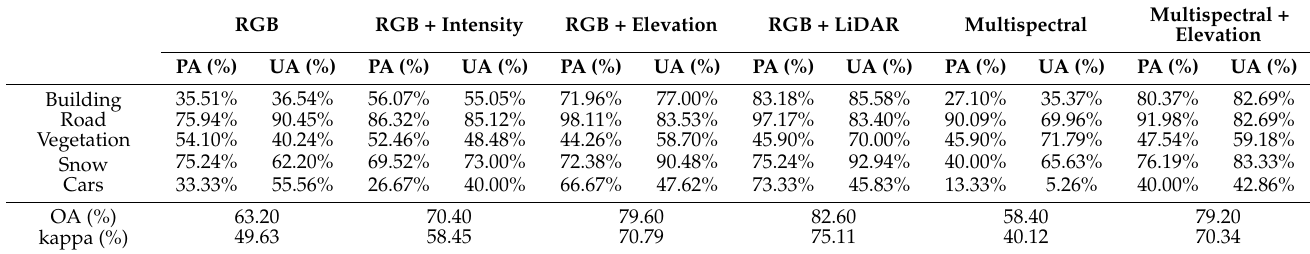
Table 1. Classification results of the six combinations using the maximum likelihood technique.